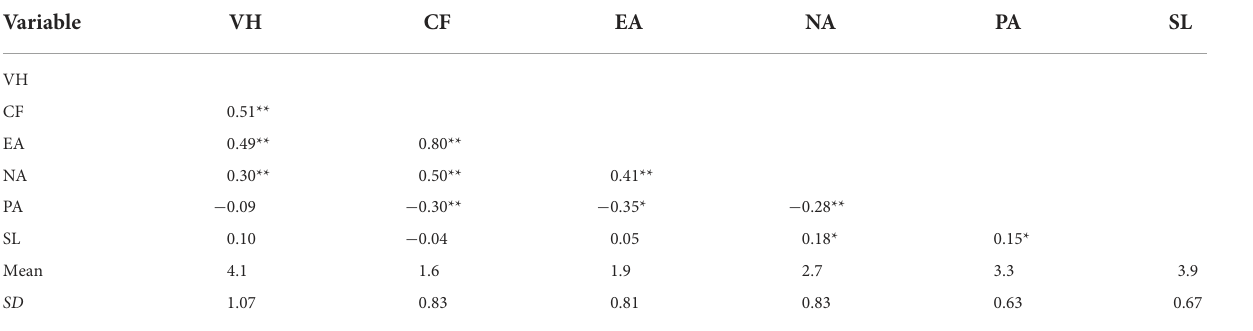
TABLE 1 Bivariate correlations, means, and standard deviations.